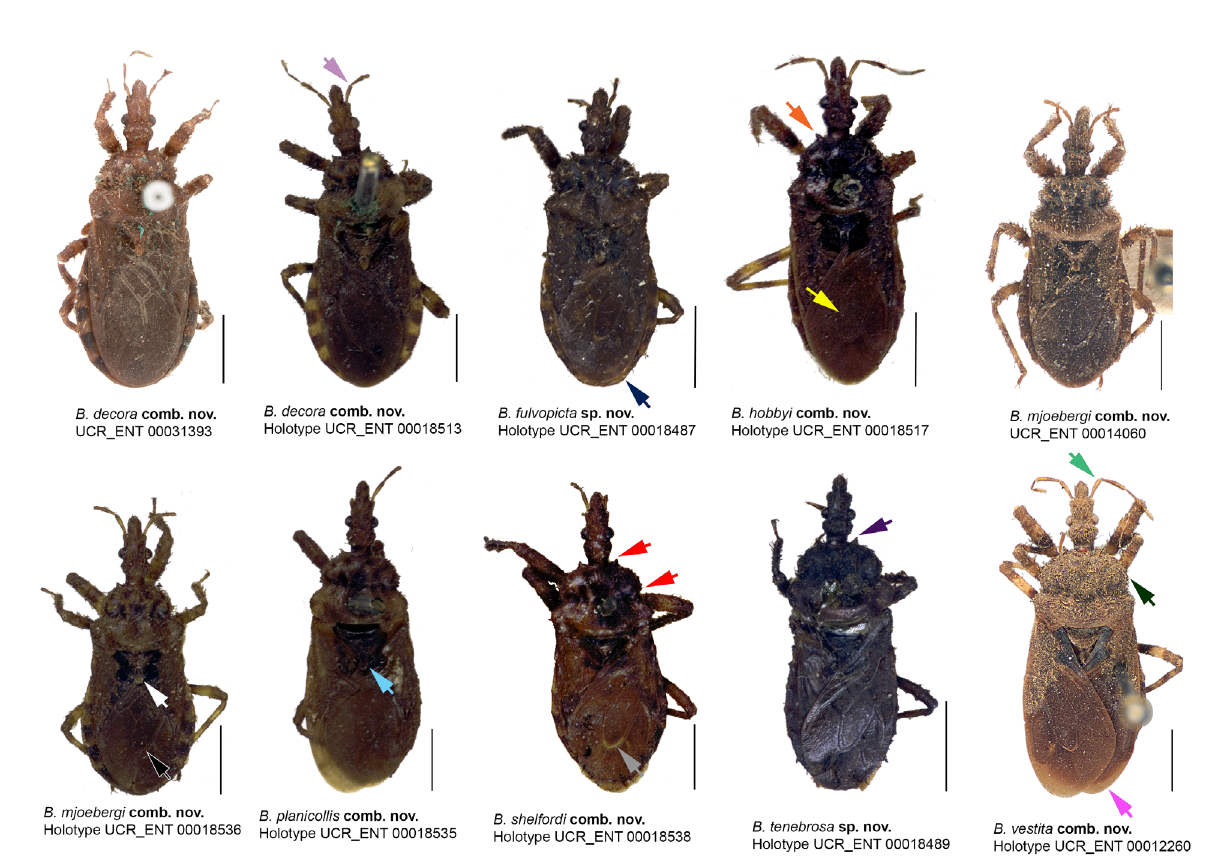
Fig. 4. Dorsal habitus images for species of Breviphysoderes gen. nov. For an explanation of the colored arrows, see key on page 17. Scale bars = 2